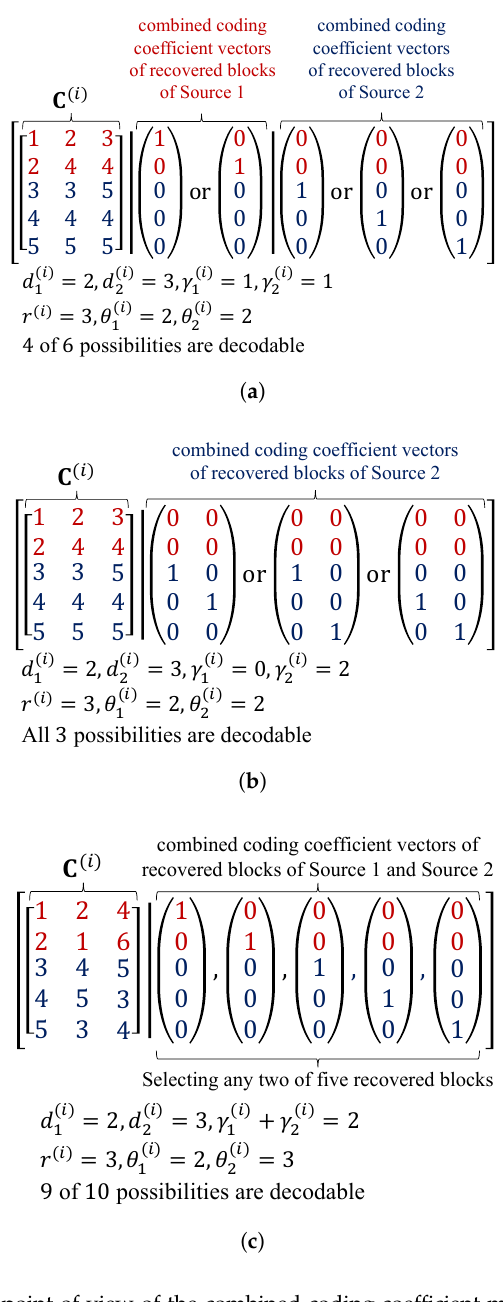
= 0, γ ( i ) = 2, θ ( i ) = 2, θ ( i ) = 2; ( c ) γ ( i ) 2 2 1 1